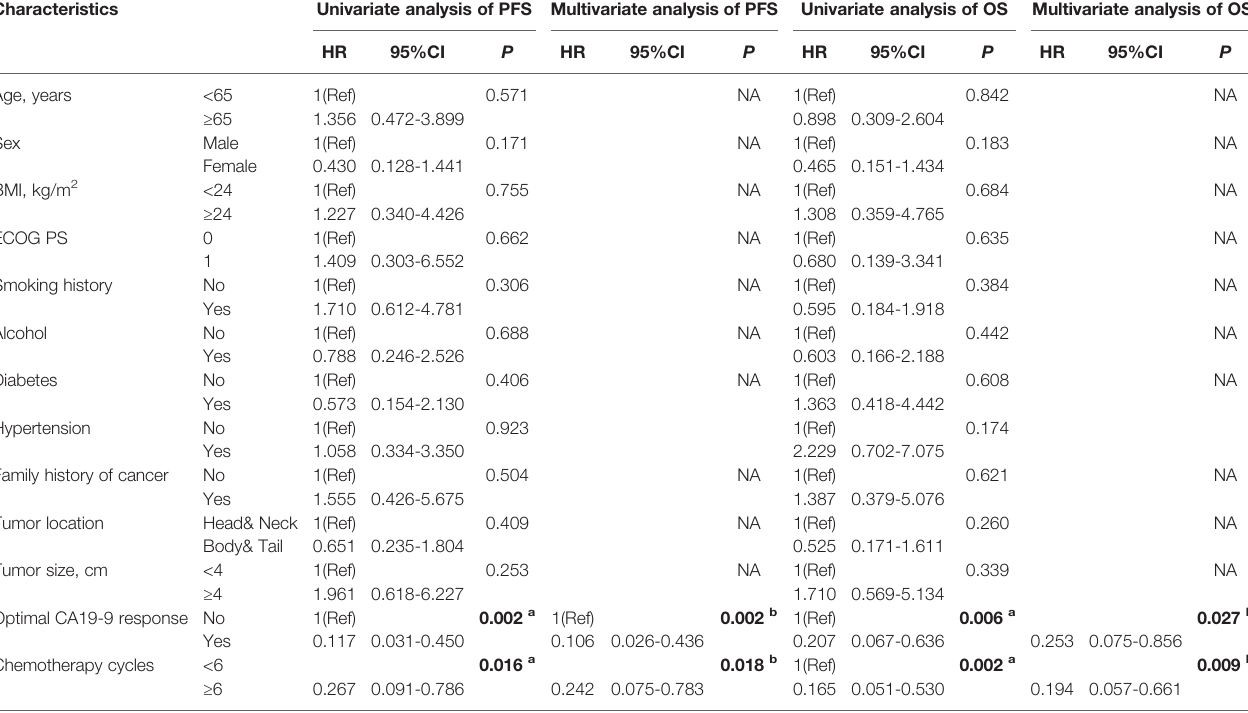
TABLE 3 | Stepwise univariate and multivariate Cox regression analyses to identify predictors of PFS and OS.